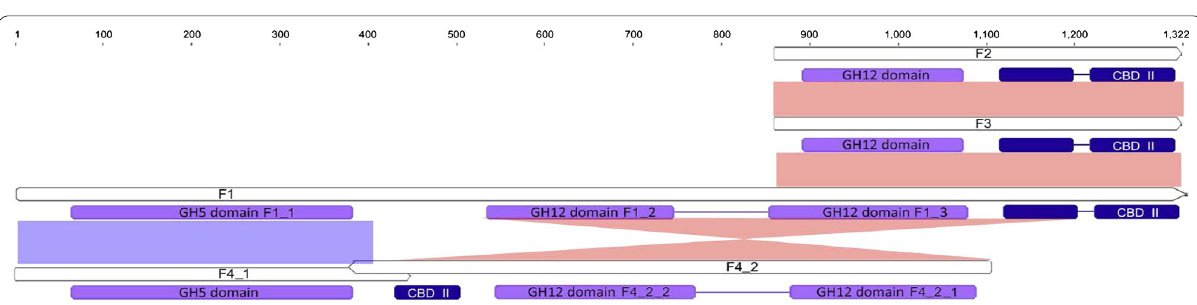
Fig. 3 Module annotation of the cellulases F1, F2, F3, F4_1 and F4_2, as predicted by interproscan (Jones et al. 2014). Cellulase modules are labeled in purple, and CBM modules are labeled in blue. Identical regions between different cellulase sequences are presented in light blue and